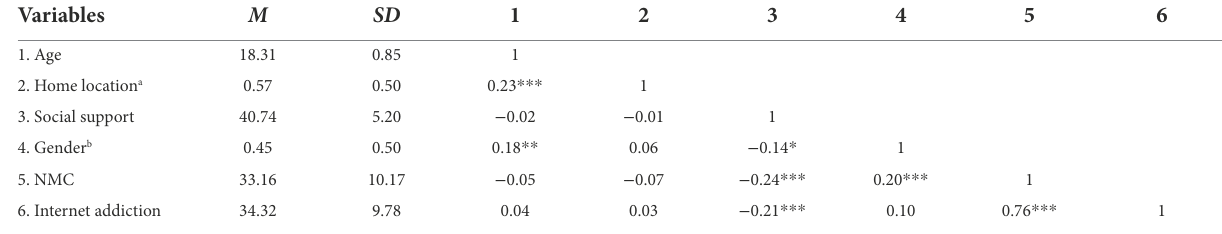
TABLE 1 Means, standard deviation, and correlations ( n =